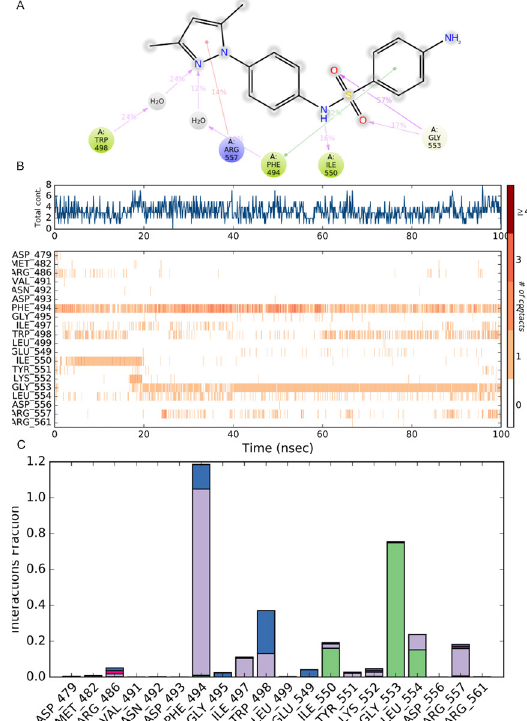
Figure 7. Protein–compound 2C contacts: ( A ) the interactions that occur for more than 10% of the simulation time are reported; ( B ) a timeline representation of the interactions and contacts (H-bonds, hydrophobic, ionic, and water bridges) during the simulation; ( C ) histogram of protein–compound 2C interactions fractions: hydrogen bonds (green), hydrophobic (purple), ionic (red), and water bridges (blue).